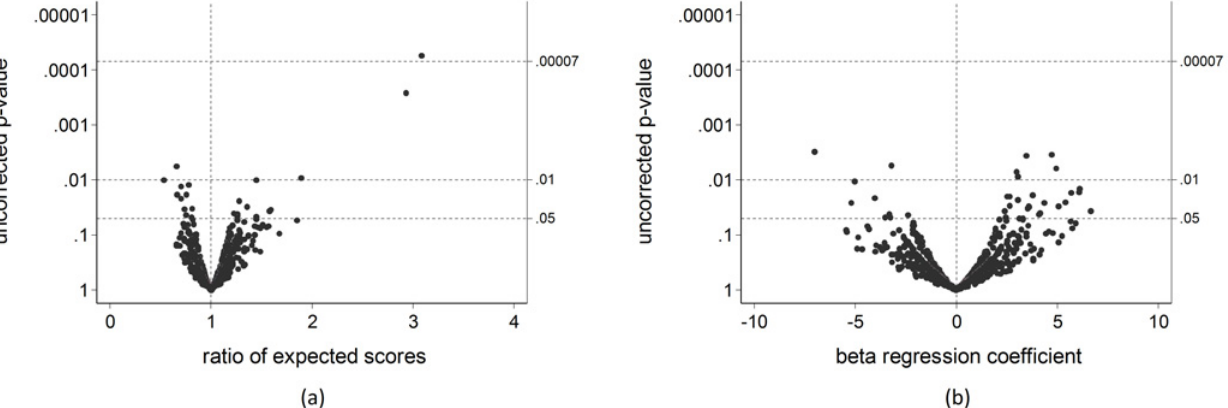
Fig 3. Associations of 236 SNPs in 51 candidate gene regions with the symptom and treatment score (a) and pre-bronchodilator FEV 1 % predicted (b), according to the additive, dominant and recessive genetic models. Data represent the measure of association and the uncorrected p-value for the association of each SNP with the outcome. The FDR-corrected cut-off (0.00007) for statistical significance is